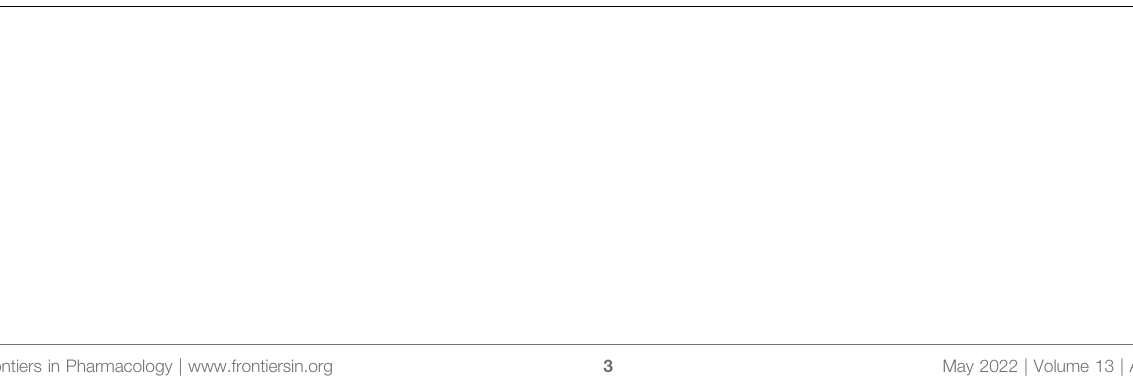
Frontiers in Pharmacology |